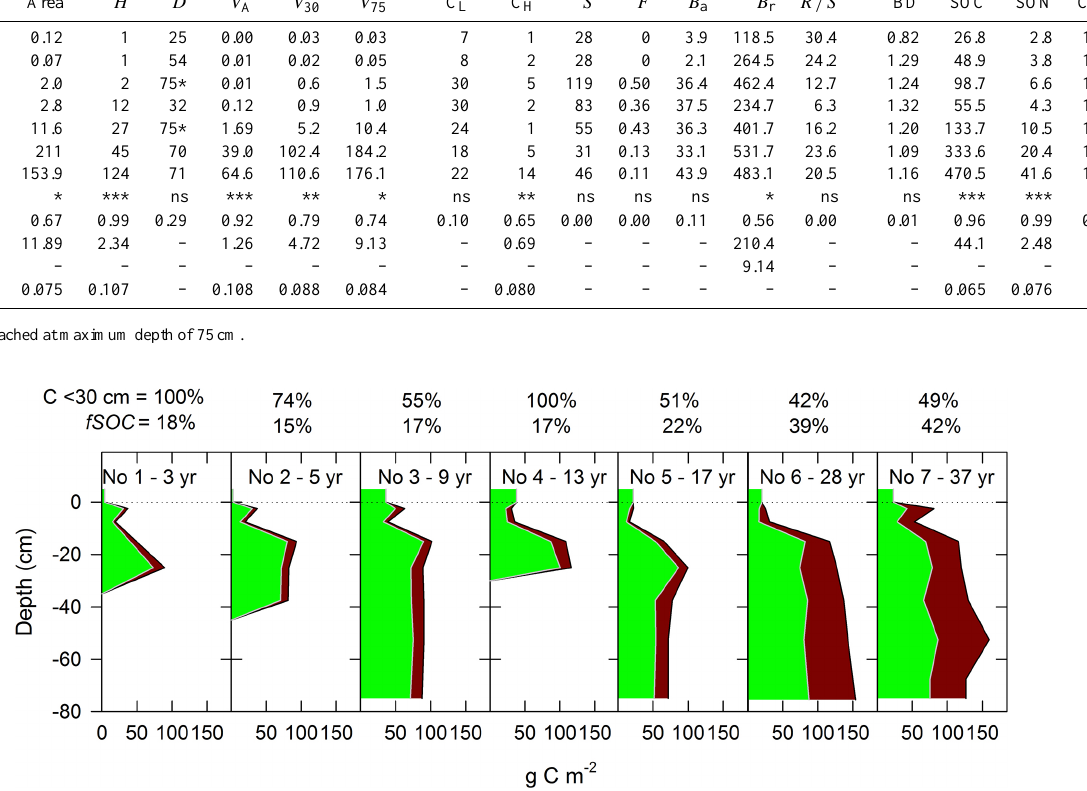
Figure 2. Distribution of aboveground (green, in carbon units, above the dotted line) and belowground plant biomass (green, below the dotted line) and soil organic carbon (brown) in a chronosequence of seven Leymus arenarius dunes on Surtsey ranging in age between 3 and 37 years. The profiles are all from the top of each dune. Above the diagram are the fractions of total ecosystem C stock found above 30cm depth and the fraction of ecosystem C stock in soil organic matter ( f